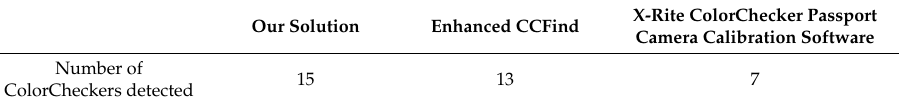
Figure 5. Dataset of 15 RAW images with CC evaluated. Table 1. Number of ColorCheckers detected by different algorithm.